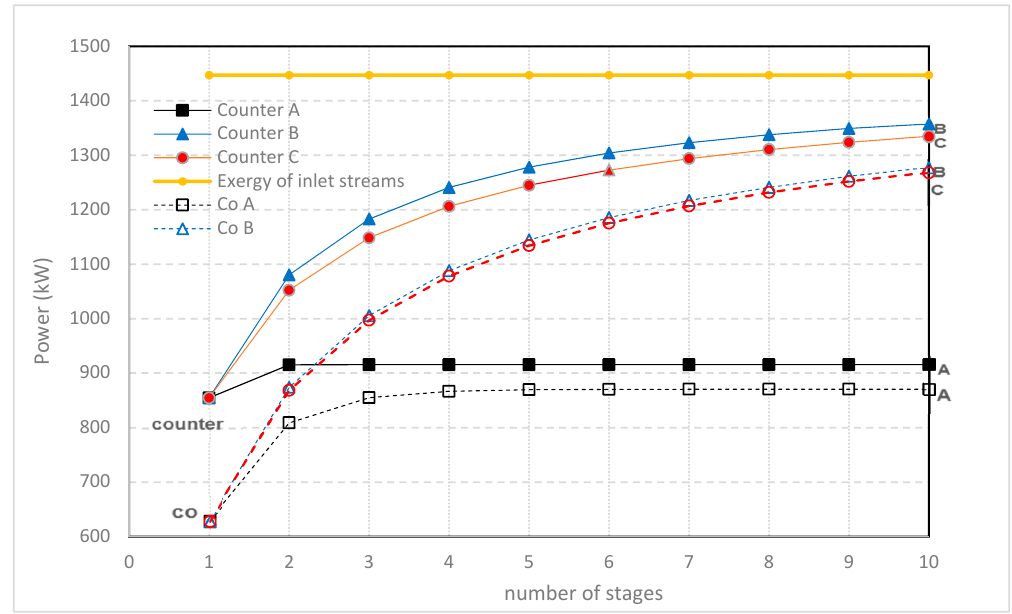
Figure 10. Power in kW with multistaging in co-flow stacks (dashed lines; added to aid interpretation) and counterflow stacks (solid lines). Stacks are external connected in co-flow. Feed-water-flow rate is 1 m 3 /s, concentrations 1 and 30 kg/m 3 . Three different optimizing methods (A, B and C) are used (see caption Figure 9).